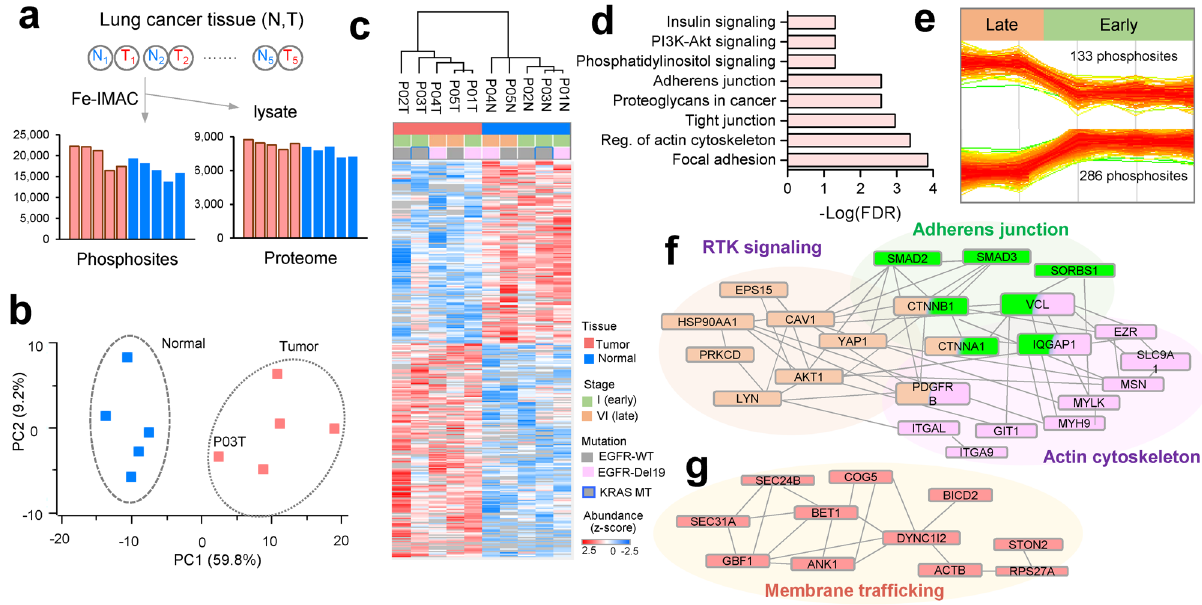
Fig. 6 Phosphoproteome pro fi ling of lung cancer tissues. a Summary of phosphosite and protein-level identi fi cation results in each tumor (T) and adjacent normal (N) lung cancer tissue. b Principal component (PC) analysis of tumor and adjacent normal tissues using differentially expressed sites normalized to protein level (two-sampled t -test, p < 0.05, S0 = 0.1). c Unsupervised clustering of 585 (normalized) differentially expressed phosphosites between tumor and normal tissues (two-sampled t -test, p < 0.05, S0 = 0.1). d Pathway analysis of upregulated phosphosites by the Kyoto Encyclopedia of Genes and Genomes (KEGG) database (FDR < 0.05). e Differentially expressed phosphosites showing increasing or decreasing expression between early and late stages (two-sampled t -test, p < 0.05, S0 = 0.1). Protein – protein interaction network and functional category of phosphoproteins for f upregulated in the early and g upregulated in late stages fi ltered with medium con fi dence and FDR < 0.05 in STRING database (https://string-db.org/). Source data are provided as a Source Data fi